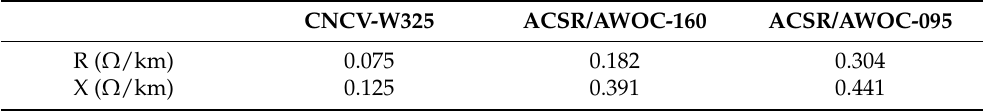
Table 1. Line parameters of the distribution